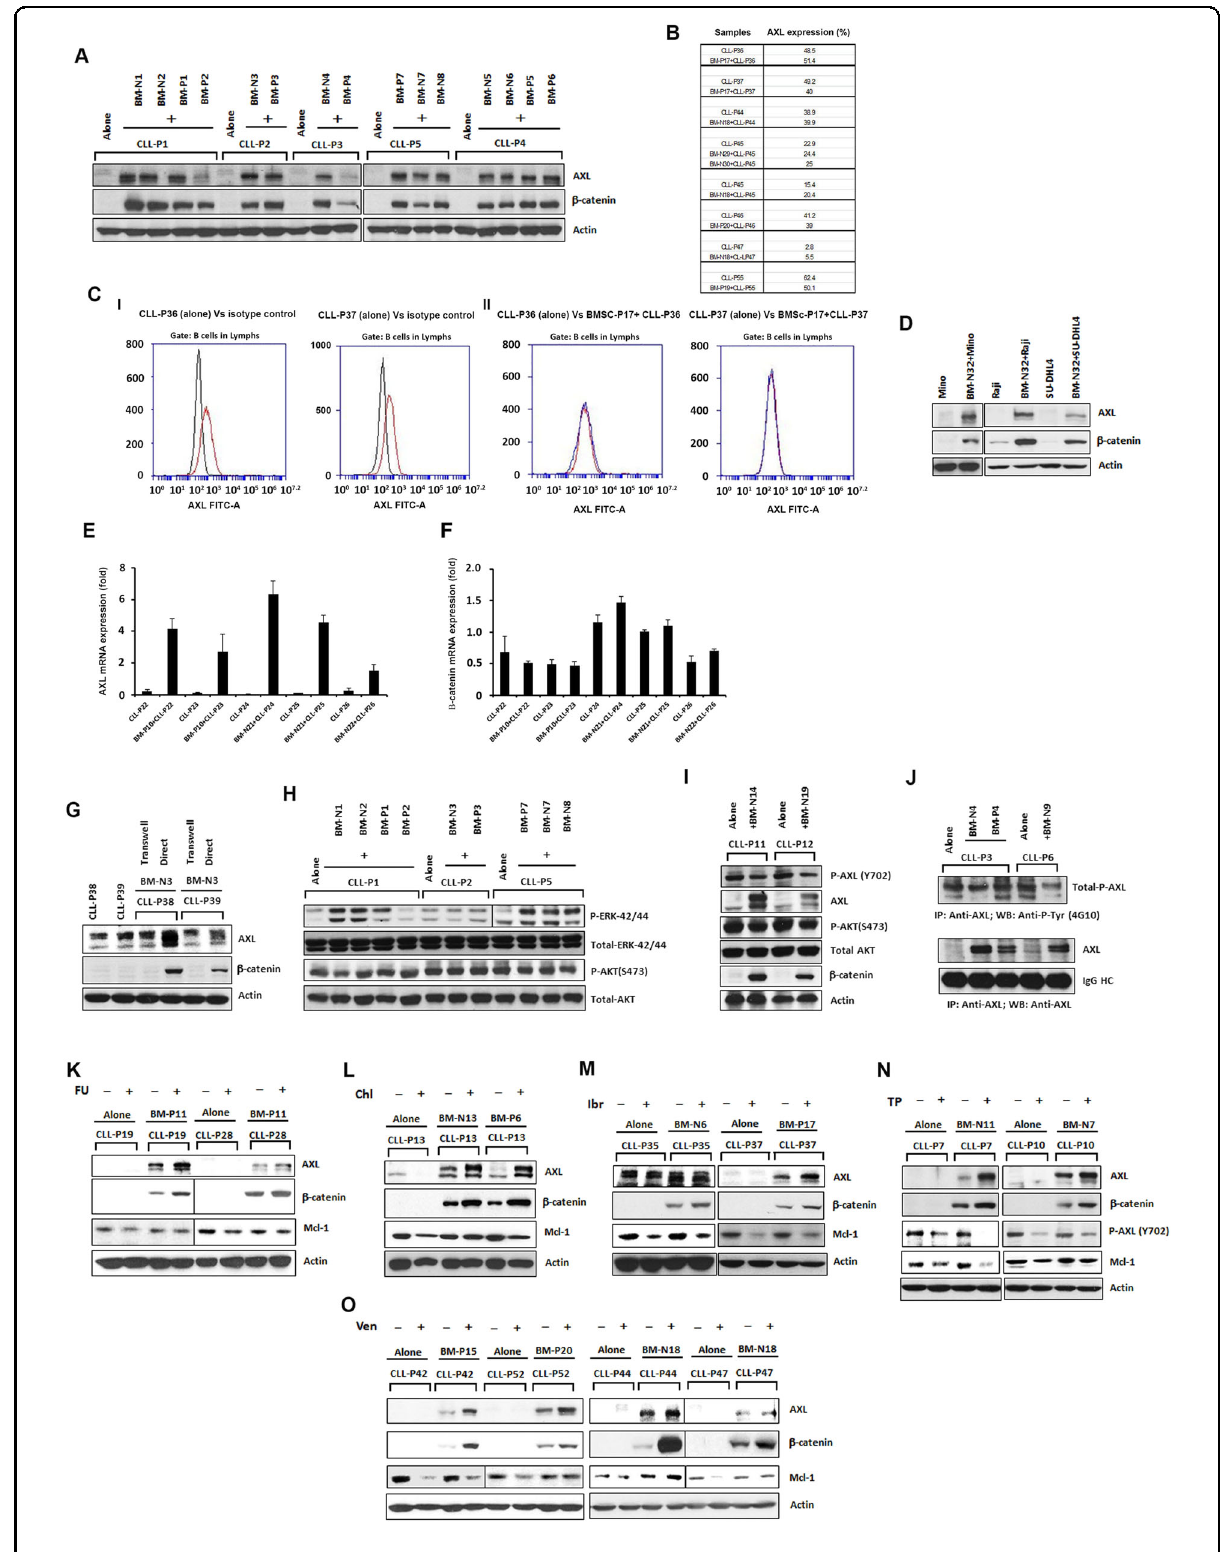
Fig. 1 (See legend on next